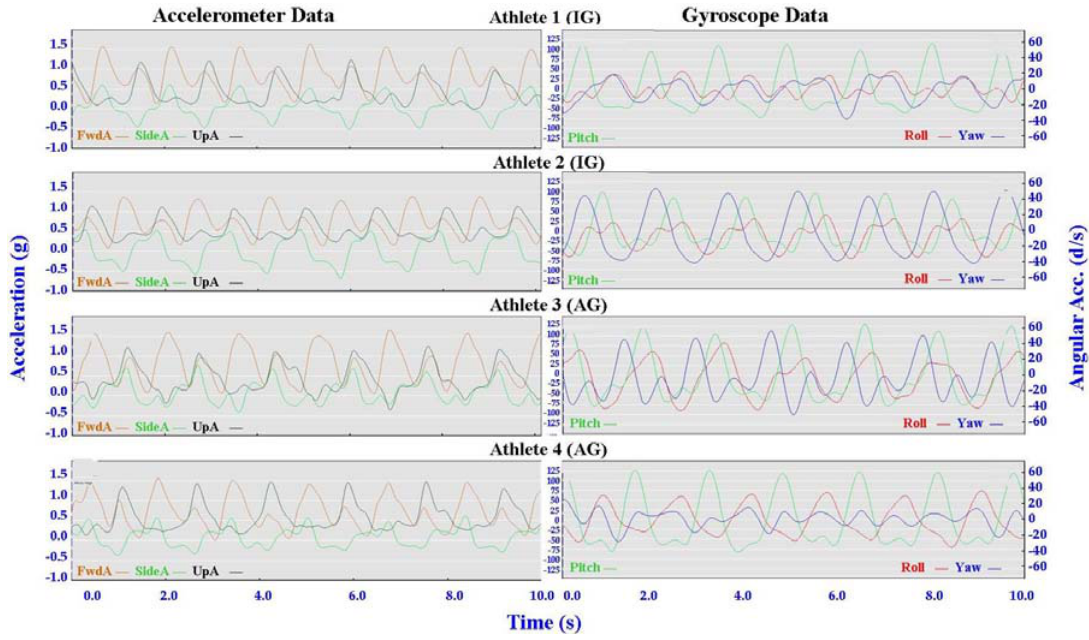
Figure 15. Comparison of Single Time (G4) gyroscope and accelerometer traces for four athletes (two from the IG and two from the